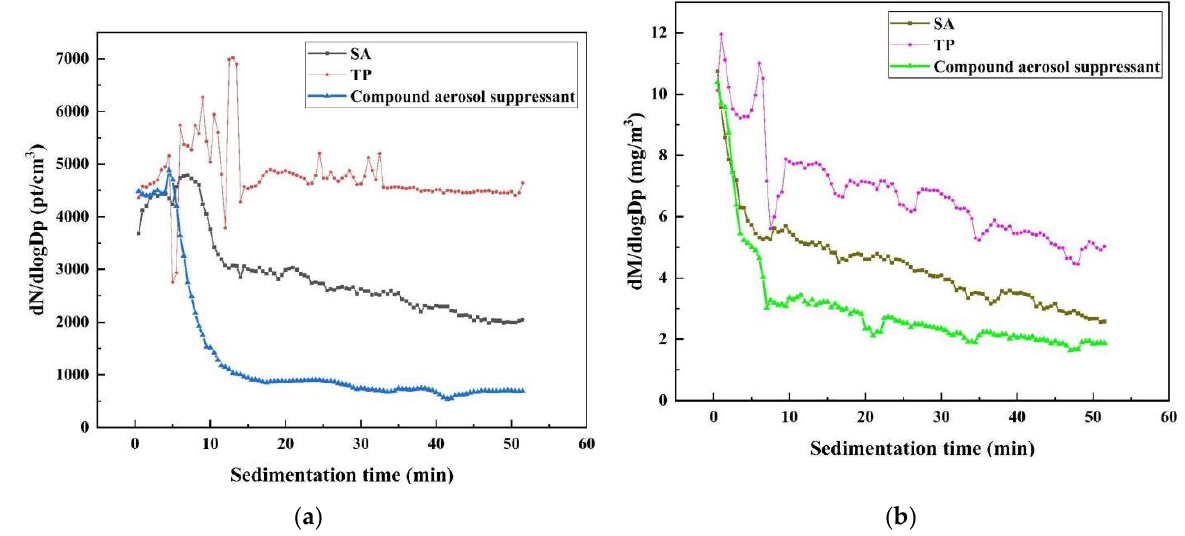
Figure 3. Change in aerosol particle concentration over time: ( a ) change in aerosol particle number concentration over time after spraying the aerosol suppressant; ( b ) change in aerosol particle mass concentration over time after spraying the aerosol suppressant.